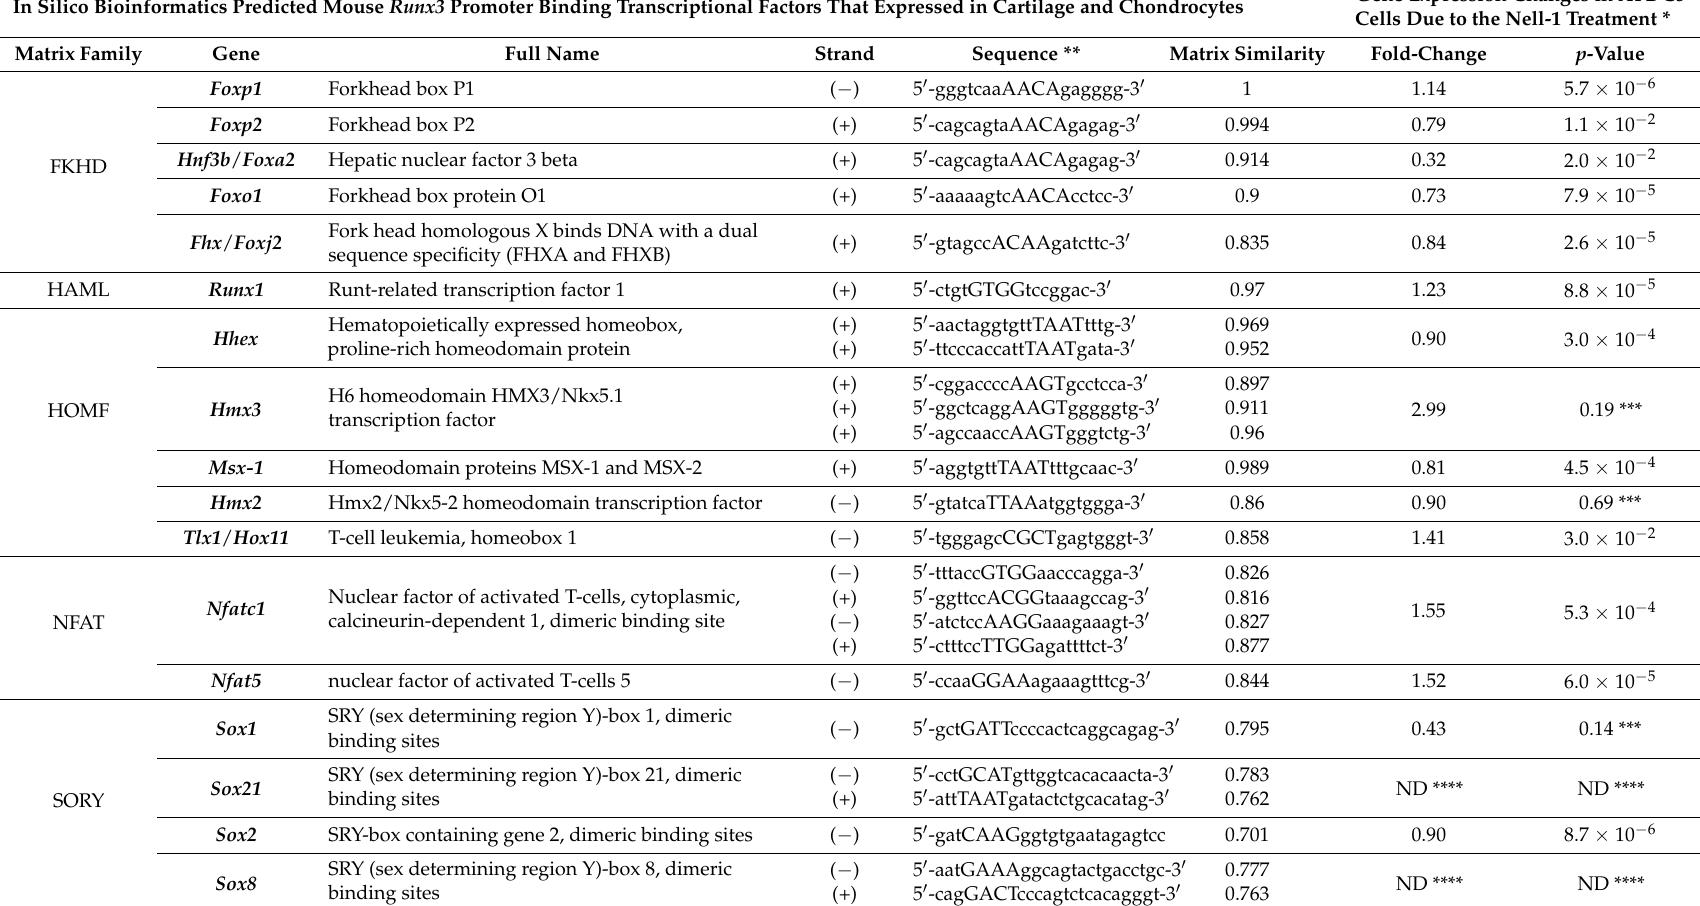
Table 1. Mouse Runx3 promoter binding transcriptional factor candidates that expressed in cartilage and chondrocytes. In Silico Bioinformatics Predicted Mouse Runx3 Promoter Binding Transcriptional Factors That Expressed in Cartilage and Chondrocytes